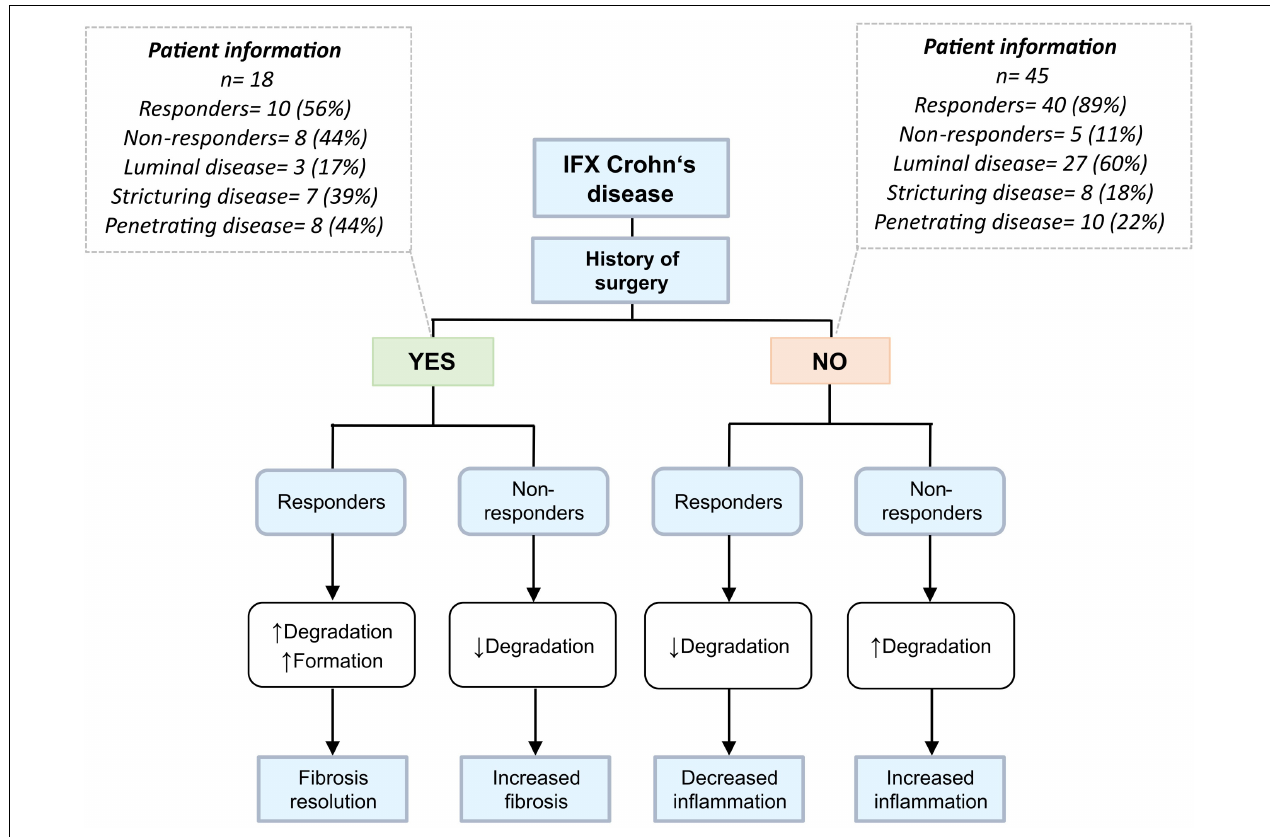
FIGURE 5 | Differing biomarker profiles based on prior history of surgery and disease behavior. Patients were stratified according to prior history of intestinal resection. Eighty-three percent of patients who have undergone prior surgery have stricturing/penetrating disease and thus a more fibrotic phenotype than patients without history of surgery, who mainly have a luminal disease phenotype. Responders within the yes-surgery group would theoretically have elevated levels of degradation markers, a possible result from the breakdown of fibrotic tissue and thus fibrosis resolution – while responders in the no-surgery group have decreased levels of aforementioned biomarkers, suggesting reduced inflammation and improved barrier